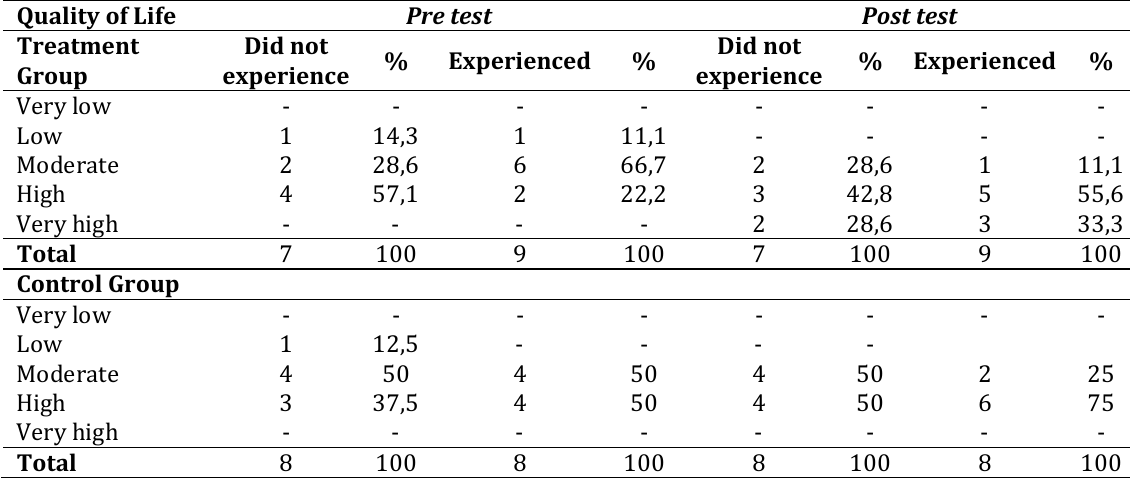
Table 8 Quality of Life in the Treatment and Control Groups Based on Complications of Diabetes Mellitus Quality of Life